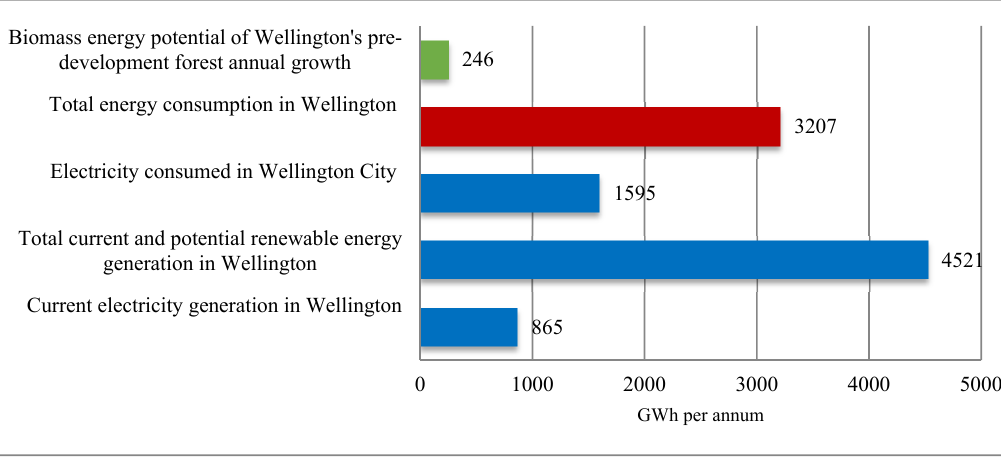
Figure 3. Energy and electricity in Wellington.